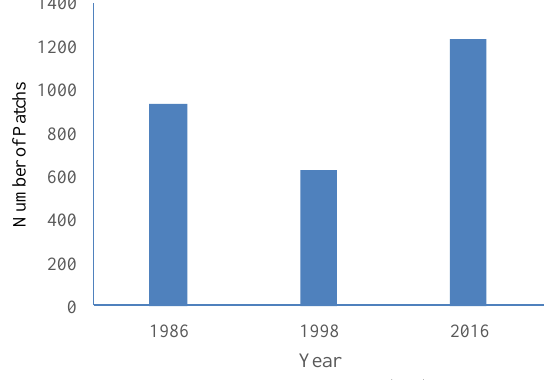
Figure 6. Changes in the Number of Patch (NP) in 1986, 1998 and 2016